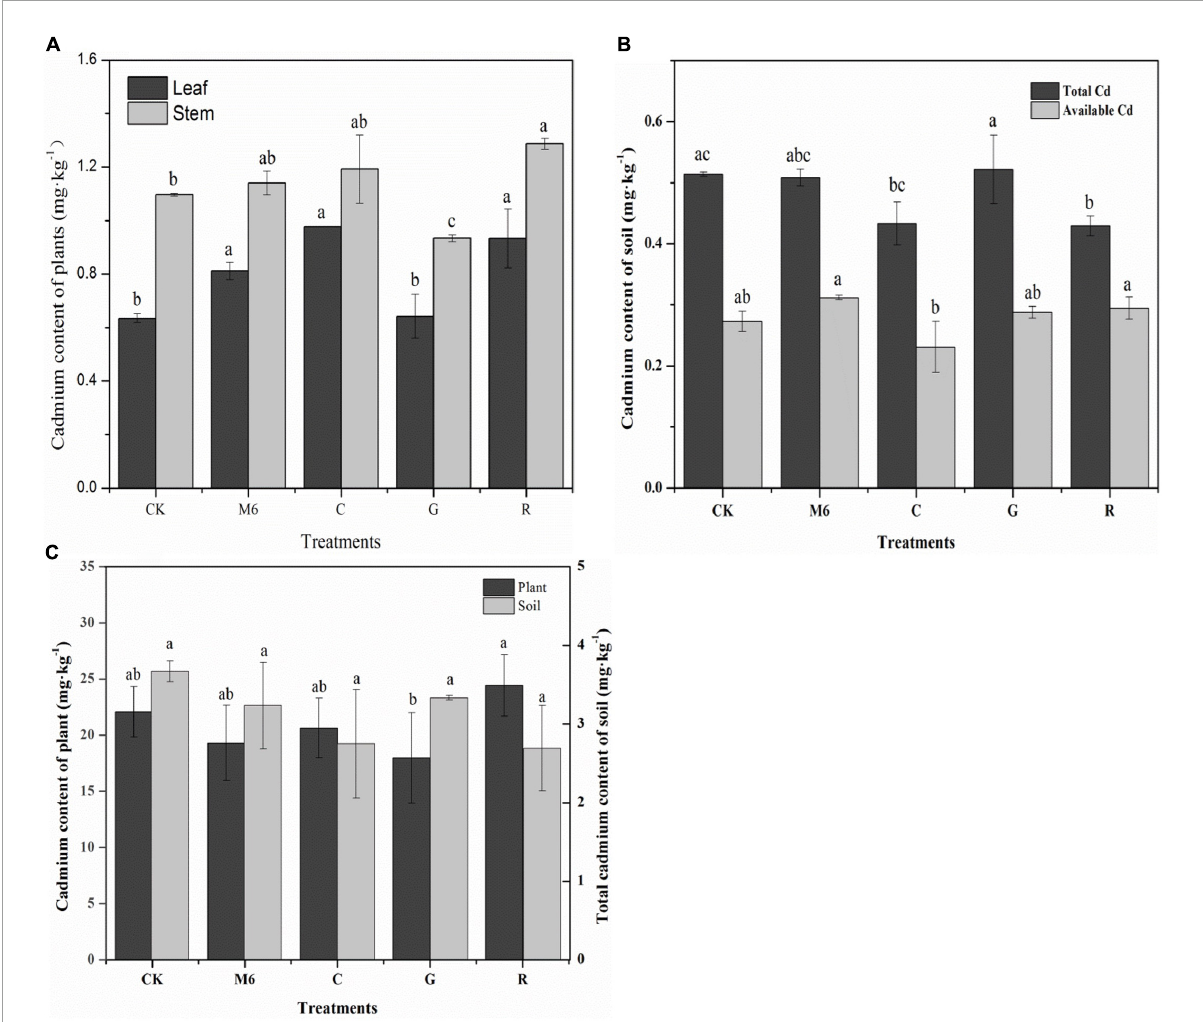
FIGURE6 Cd content in stems and leaves of Sedum alfredii (A) and total Cd and available Cd content in LC soil (B) , Cd content of Sedum alfredii and total soil Cd content in HC (C) . The data is the means and standard deviations of three replicates ( n = 3). The significant differences among all treatments ( p < 0.05) are presented by lowercase letters. LC, low cadmium; HC, high